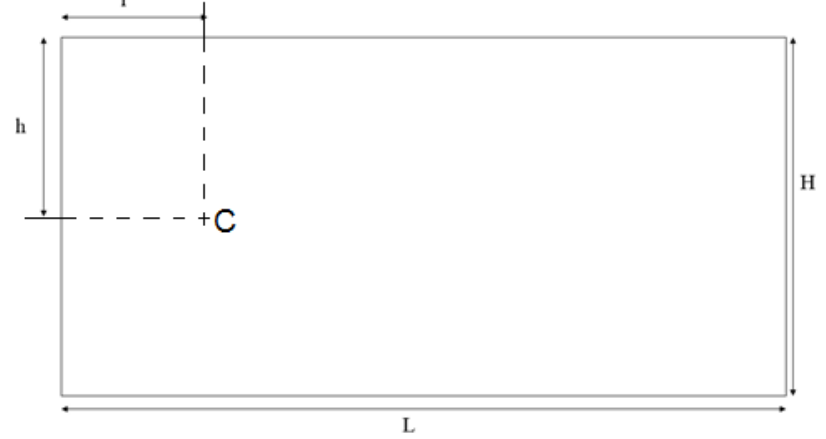
Figure 2. Computational domain.